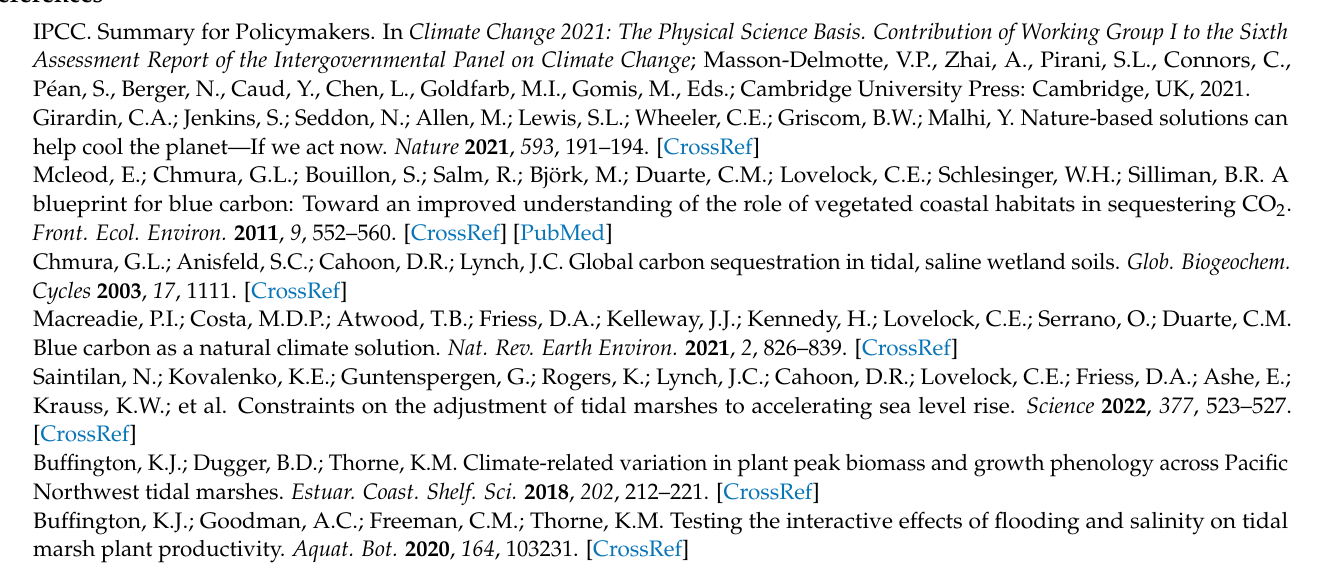
method, Figure S2: Aboveground turnover vs. dominant vegetation, Figure S3: Regional mean carbon; Table S1: Net primary productivity regions, Table S2: Aboveground turnover from literature